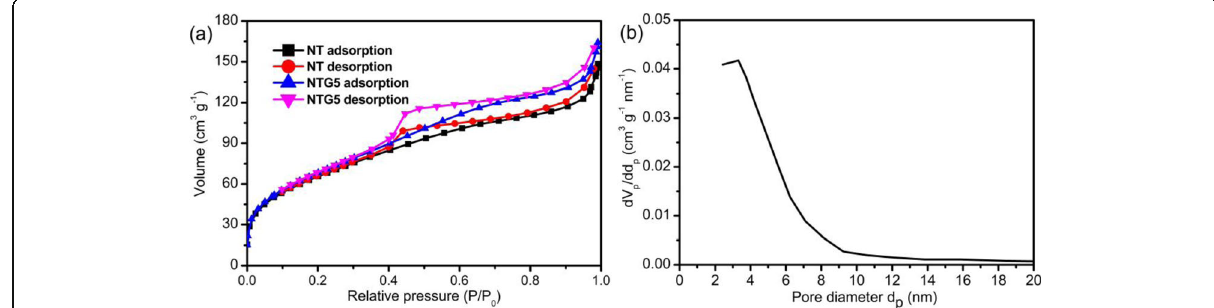
Fig. 5 (a) Nitrogen adsorption-desorption isotherms of NT and NTG5 photocatalysts and (b) The corresponding BJH pore size distribution plot of